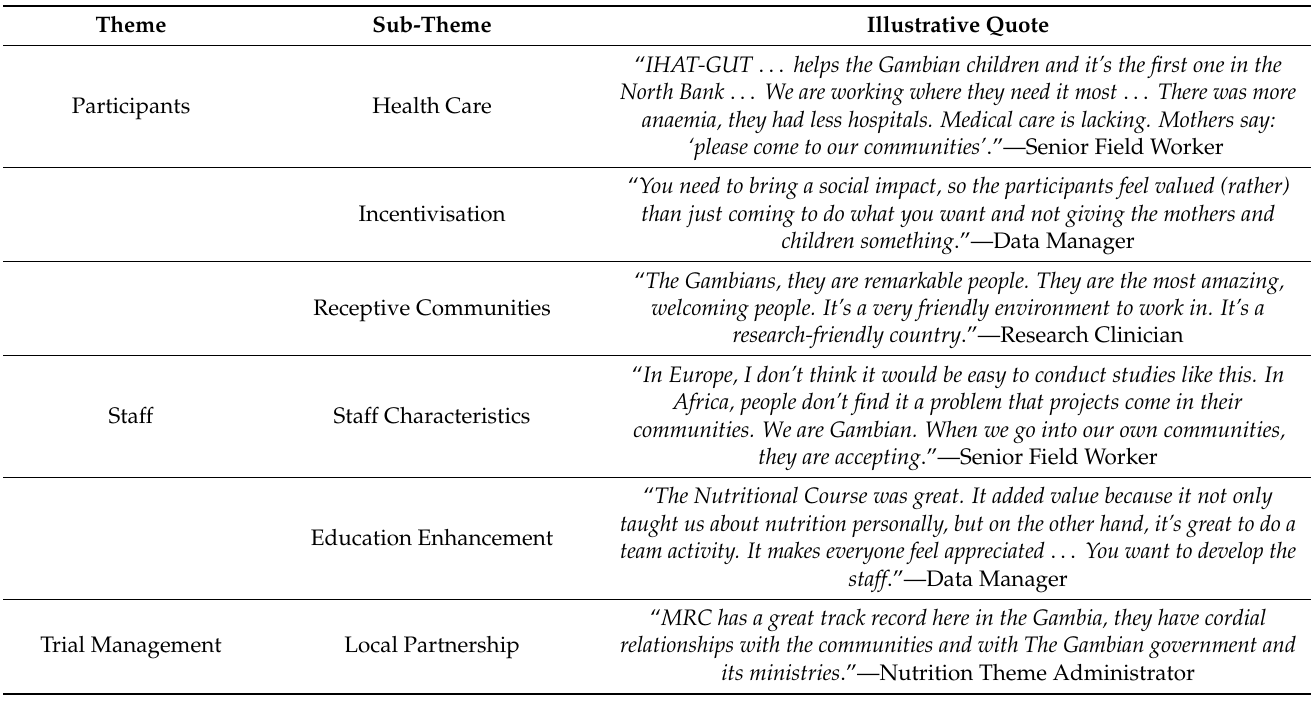
Figure 4. Graphical illustration of themes and sub-themes of the facilitators. Table 4. Illustrative quotes for each sub-theme of the